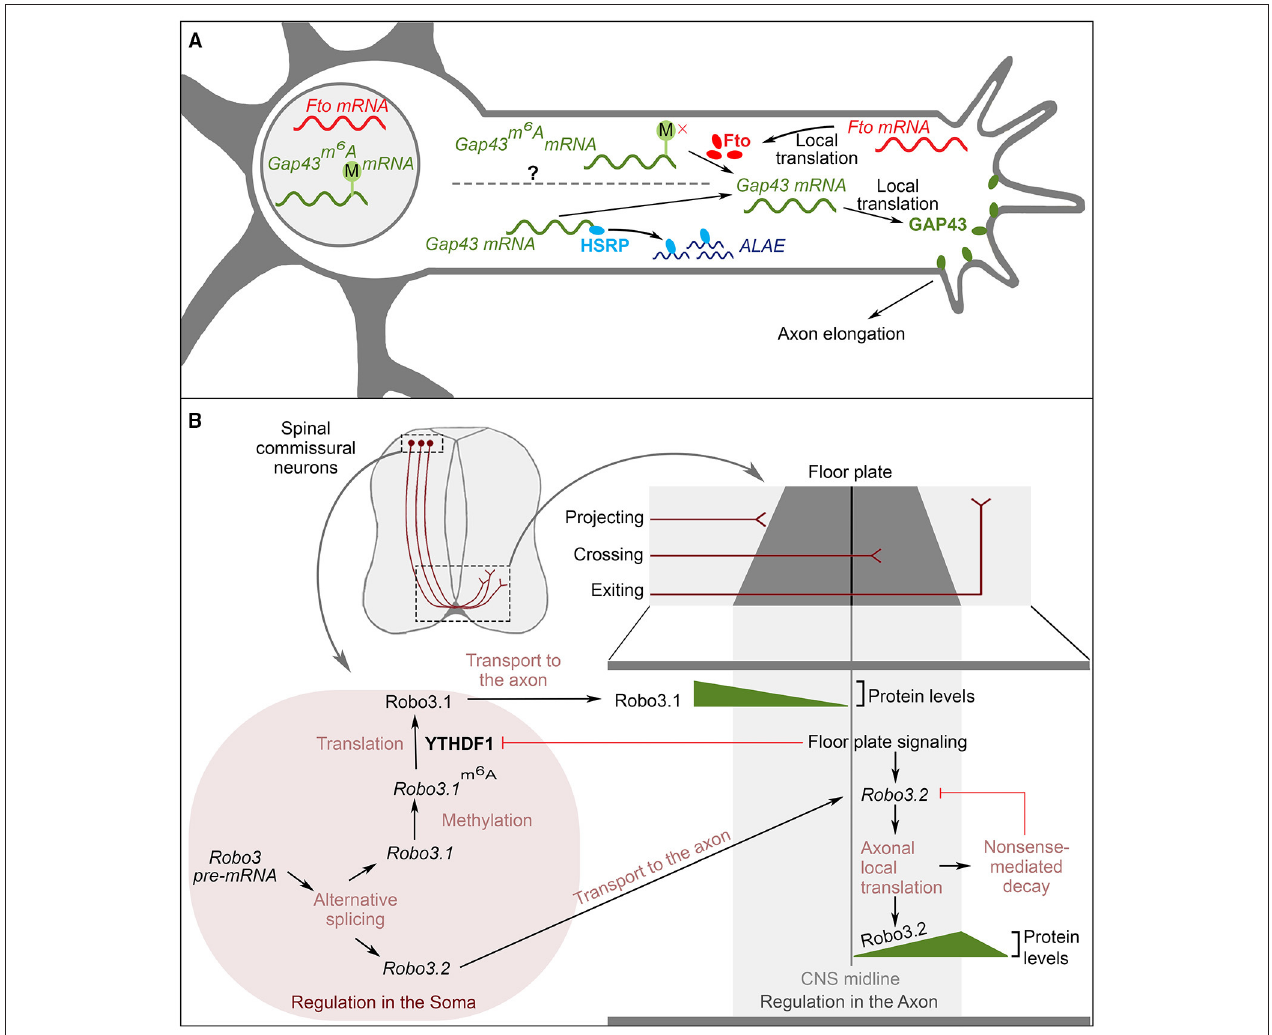
FIGURE 3 | The interplay of RNA modification and local translation for neuronal wiring (A) Regulation of local translation of Gap43 mRNA for axon elongation. FTO mRNA is locally translated in axons. The eraser FTO mediates the de-methylation of Gap43 m 6 A mRNA in axons. This leads to local translation of Gap43 mRNA. Via an alternative pathway, HSRP binds to the 3 ′ UTR of Gap43 mRNA to repress its translation. The non-coding RNA ALAE is enriched in the axon and sequesters HSRP. Released Gap43 mRNA can then be translated locally. Gap43 associates with the plasma membrane and regulates actin dynamics to promote axon elongation. The question mark on the dotted line highlights that it is unknown whether these two pathways interact. (B) RNA metabolism of Robo3 involved in midline crossing of commissural neurons. (Top) Cross-section of spinal cord showing the trajectory of commissural neurons. During development, these neurons project their axons ventrally, where they cross the midline to target the contralateral side. (Bottom) Robo3 RNA metabolism leads to spatially and temporally controlled expression of Robo3 during navigation of commissural axons. (Left) Events occurring in the soma. (Right) events occurring in the axons. Robo3 can produce 2 isoforms via AS, Robo3.1 and Robo3.2 . From these isoforms, Robo3.1 is methylated, and the m 6 A modification is read by YTHDF1, which stimulates translation of Robo3.1 m 6 A in the soma. When commissural axons reach the floor plate, signaling from the floor plate downregulates YTHDF1 expression, thus inhibiting Robo3.1 expression in post-crossing axons. At this point, floor plate signaling induces the local translation of the Robo3.2 isoform. After translation, Robo3.2 is degraded by nonsense-mediated decay. Growth cones projecting to the floor plate express Robo3.1 only. After reaching the floor plate, the protein levels of Robo3.1 decrease and Robo3.2 protein levels increase. Shortly after crossing the midline, Robo3.2 protein levels are